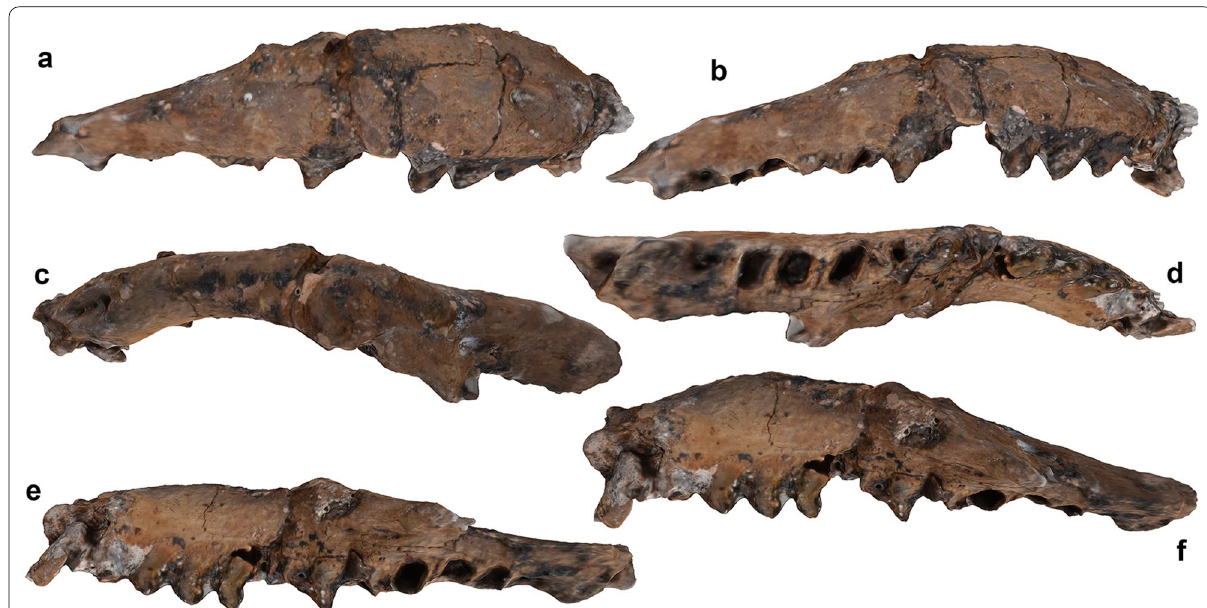
Fig. 72 Eoconstrictor spinifer comb. nov. from quarry Cecilie I, Geiseltal—part of the lectotype (herein designated): 3D models of the right maxilla (GMH Ce I-5826-1926) in labial ( a ), ventrolabial ( b ), dorsal ( c ), ventral ( d ), medial ( e ), and dorsomedial ( f ) views. Images not to the same